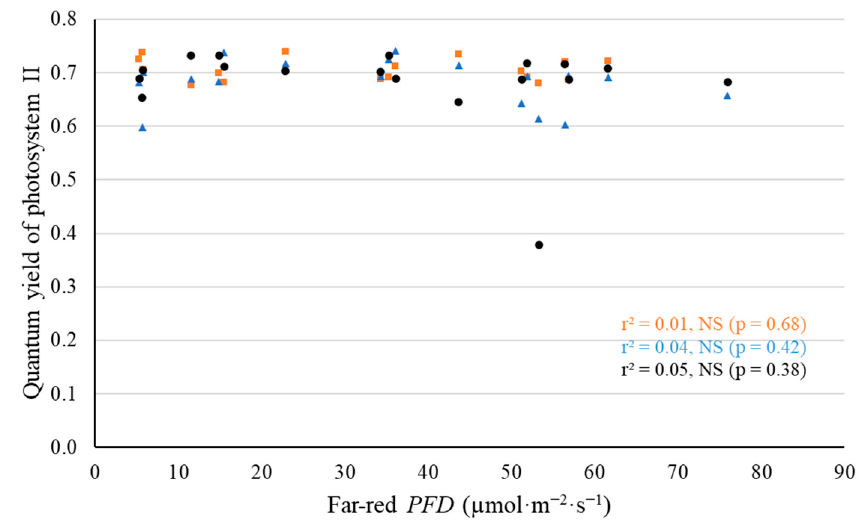
Figure 9. With a background of 204 µmol·m − 2 ·s − 1 white LED light, supplemental far-red photons had no effect on quantum yield of photosystem II at 27 days after the start of far-red light treatment for ‘Cherokee’ (orange squares), ‘Green Saladbowl’ (blue triangles), and ‘Little Gem’ (black dots) let- tuce.